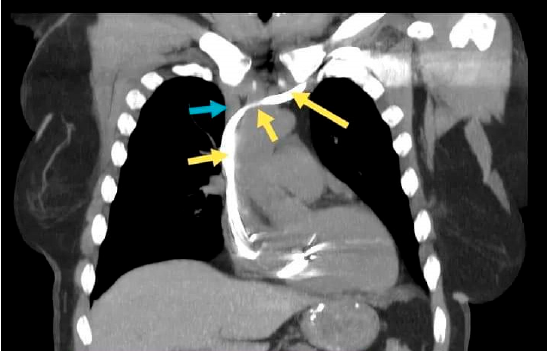
Figure 4. Coronal section. The yellow arrows: the lead in the subclavian vein, persistent left supe- rior vena cava, the innominate vein, and the right superior vena cava. The blue arrow: the right brachiocephalic vein.